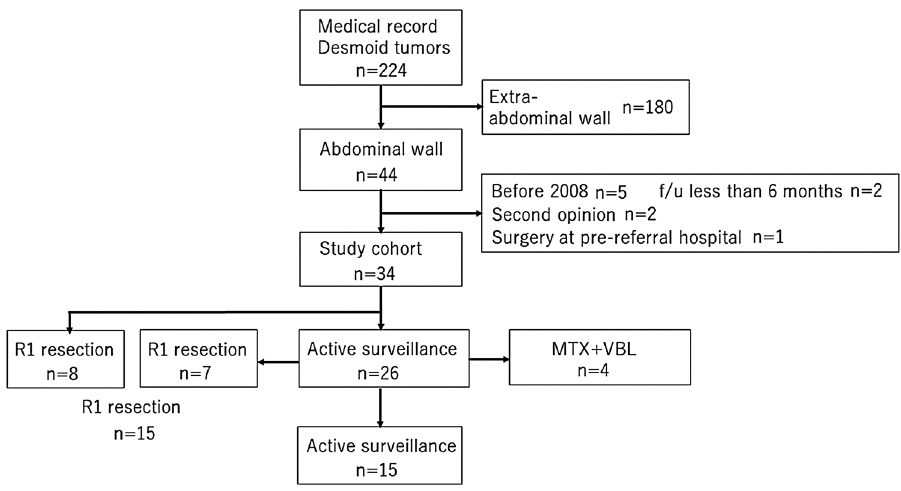
Figure 1. Flowchart of the present study. Flowchart shows the inclusion of patients in the present study. (Adobe photoshop CS6 ver.13.0 × 32, Microsoft PowerPoiont